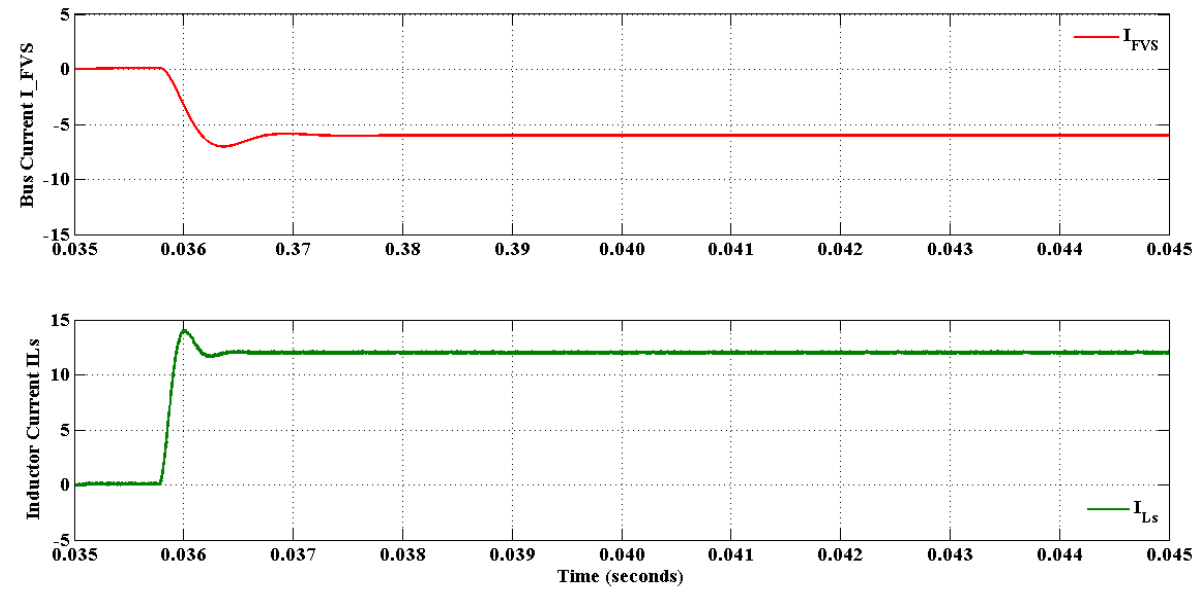
Figure 20. Regulated current step variations in inductor currents at buck mode.